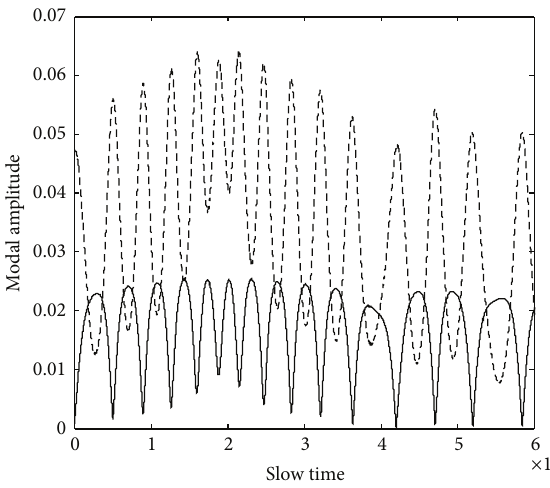
Figure 10: Undamped modal amplitudes in moving flexible arm.